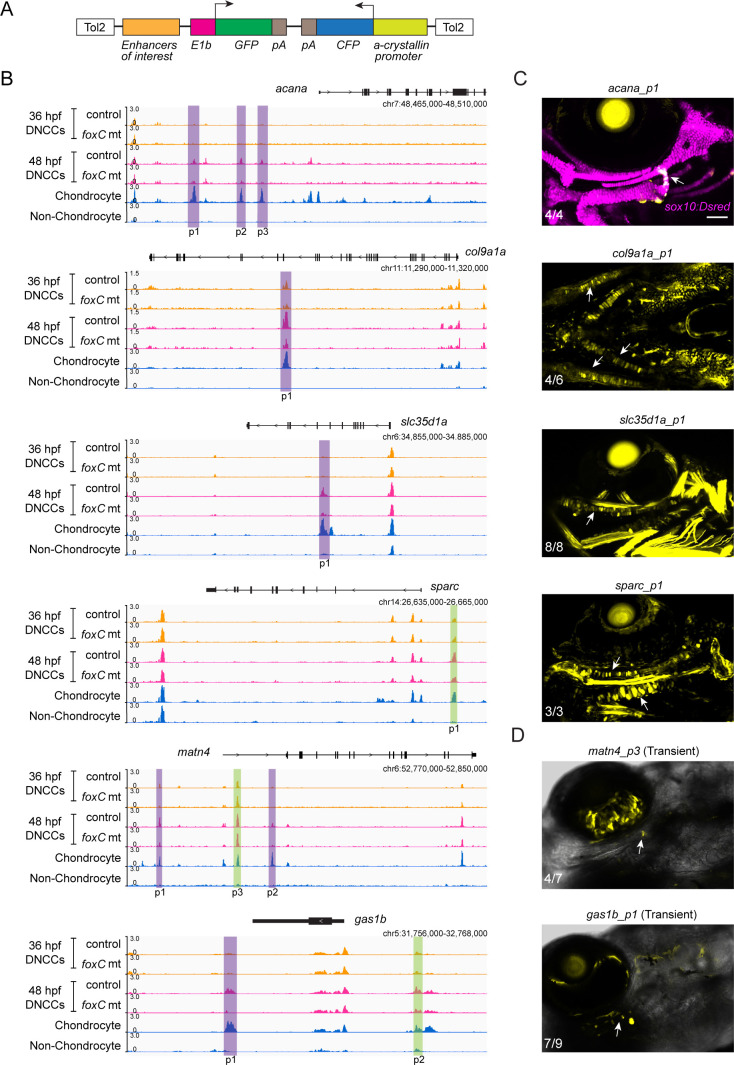
Additional in vivo validation of cartilage-enriched accessible elements.(A) Schematic of the reporter construct for enhancer testing. Tol2, transposase integration site. E1b, minimal promoter. GFP, green fluorescent protein. pA, polyadenylation sequence. CFP, cerulean fluorescent protein. (B) Snapshots of genomic regions (gene loci and GRCz10 coordinates listed) for enhancer testing. Peaks (p) tested are shown, with Foxc1-dependent regions in purple and Foxc1-independent elements in green. μATACseq reads are shown in each row for the experiments indicated, with chondrocyte and non-chondrocyte peaks from 72 hpf embryos. DNCCs, dorsal CNCCs. (C) GFP expression (yellow) driven by the indicated peaks in stable transgenic zebrafish at 6 dpf. Confocal projections of the cartilages of the first two arches are shown in lateral view for acan_p1, slc35d1a_p1 and sparc_p1 and ventral view for col9a1a_p1. For acan_p1, sox10:Dsred labels all chondrocytes for reference in magenta. Arrows indicate expression in cartilages. sparc_p1 also drives expression in ligamentocytes and osteoblasts, and slc35d1a_p1 in pharyngeal muscles. (D) Confocal sections of representative embryos injected with enhancer constructs are shown in lateral view at 6 dpf. Mosaic expression in chondrocytes (yellow, arrows) is shown, with DIC (white channel) providing embryo context. Numbers indicate proportion of embryos positive for the co-selectable lens:CFP marker (also on the injected plasmid) in which the displayed patterns were observed. Scale bar = 100 μm.